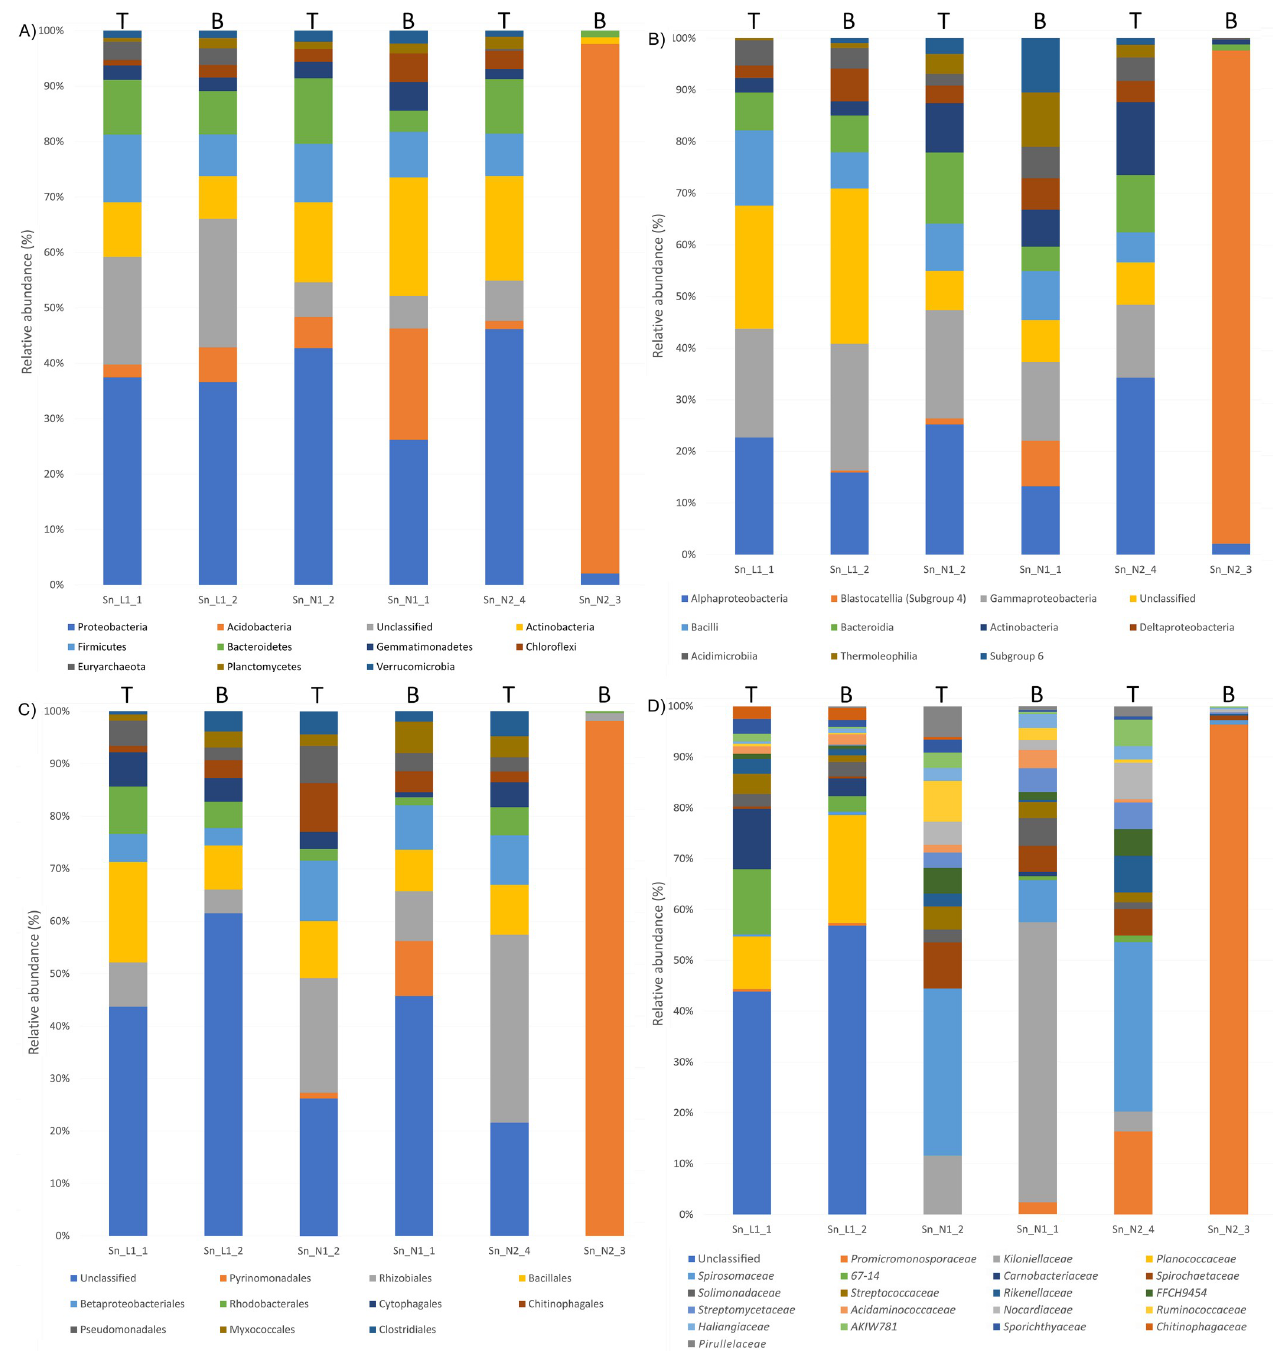
Fig 4. Percentage of the main 10 phyla (A), 10 classes (B), 10 orders (C) and 20 families (D) found in six samples of sand, collected from Linosa (indicated as Sn_L1), Ascea Marina (indicated as Sn_N1) and Eboli (indicated as Sn_N2) nests. For each nesting chamber, a sample was collected 20 cm below (indicated with a T, i.e., Top) and the other one 50 cm below the ground (indicated with a B, i.e., Bottom).